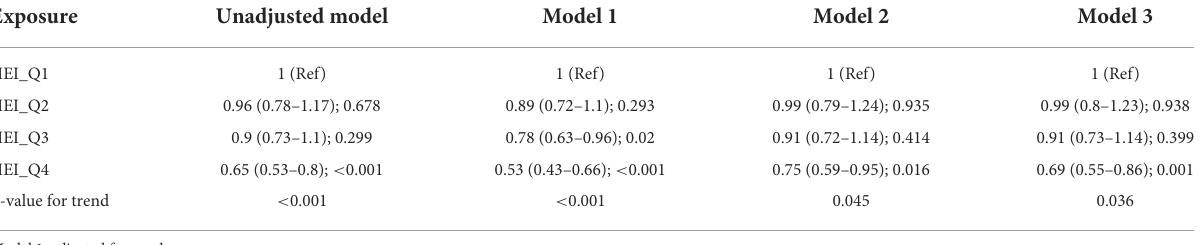
TABLE 3 Association of HEI-2015 components with periodontitis.